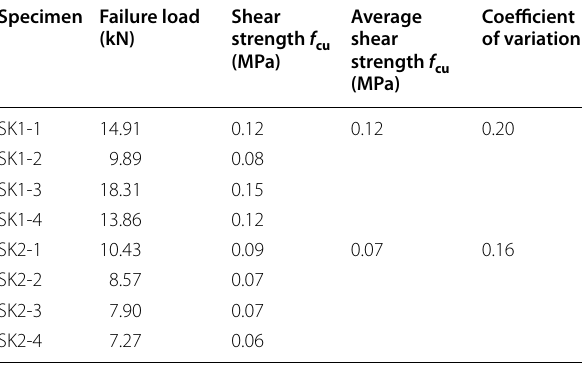
Table 4 Test values and average values of masonry shear strength.